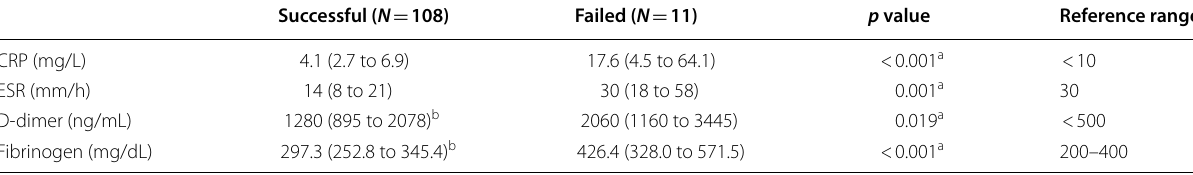
a means the data has statistical difference; b in the successful group there were 7 patients had no test result. The values are given as the median with the interquartile range in parentheses